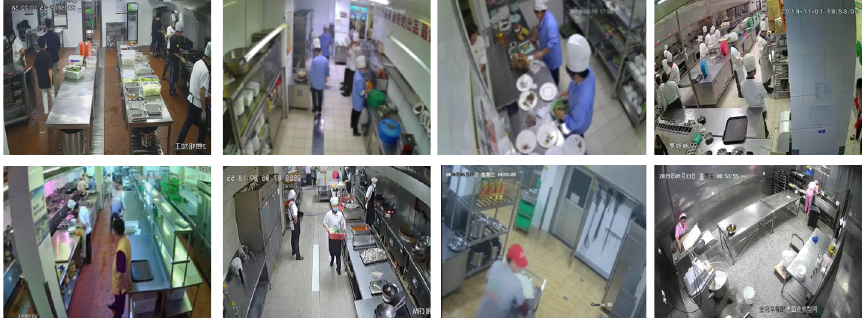
Figure 11. Display of some images from the dataset.